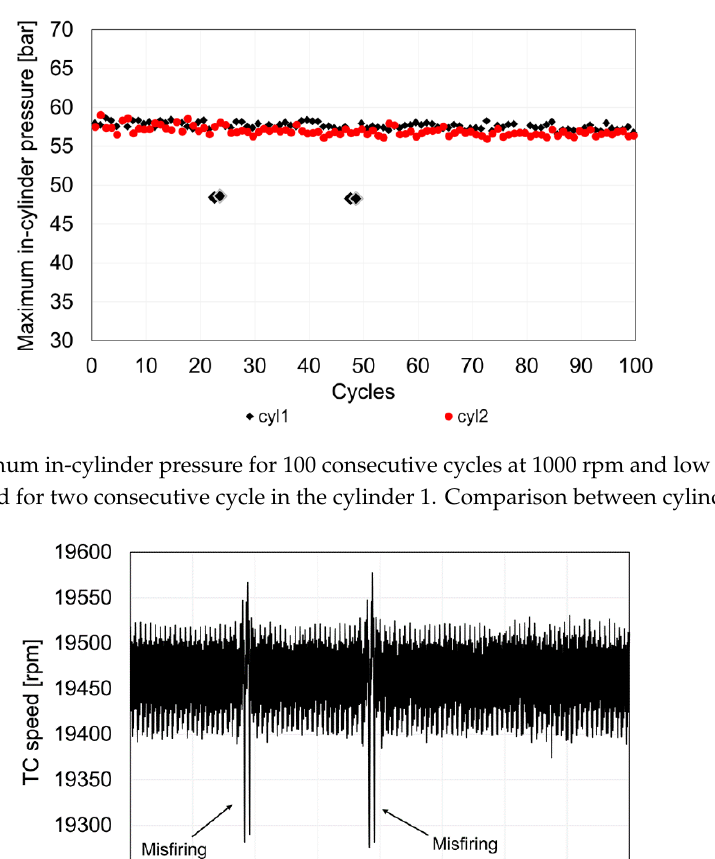
Figure 25. Minimum of the instantaneous TC speed subtracted of the average value calculated for each cylinder window of influence for 100 consecutive cycles at 1000 rpm and low load with a misfiring imposed for two consecutive cycle in cylinder 1. Comparison among all four cylinders.